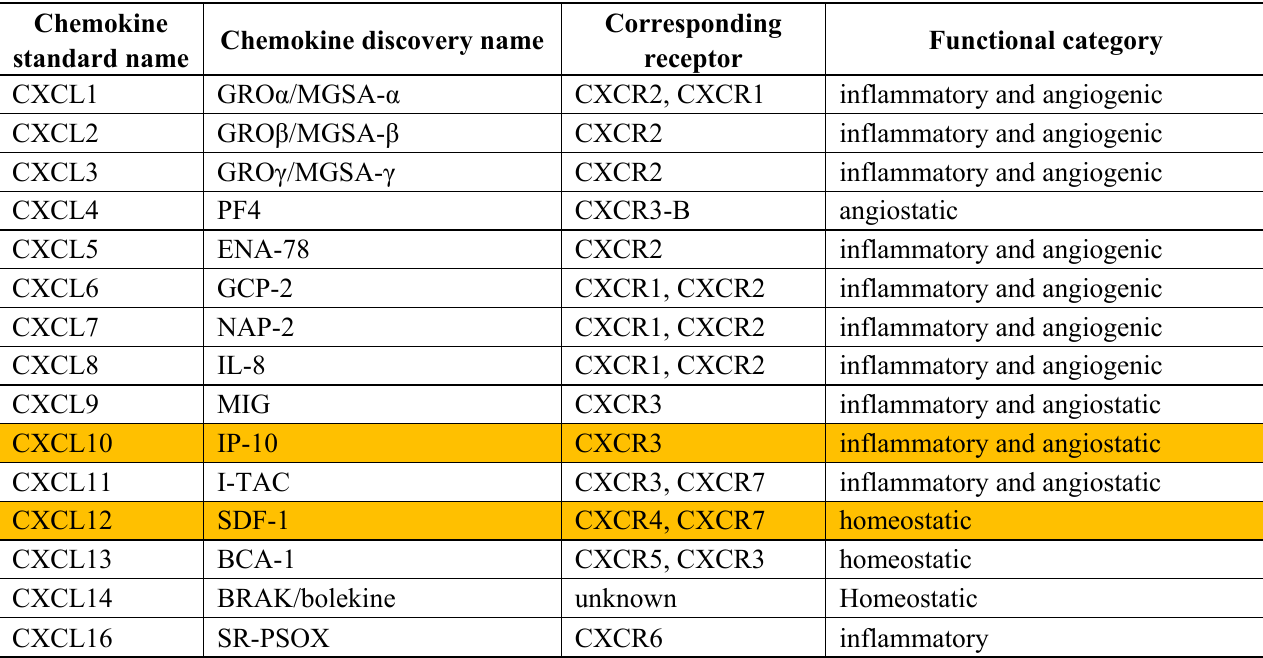
Table 1. Chemokine nomenclature, corresponding receptors, and category based on function. Adopted from [6,7]. Chemokines used as adjuvants for vaccines in murine and human studies are highlighted in